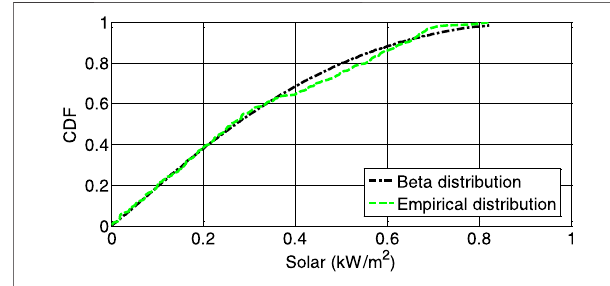
FIGURE 7 | CDF of solar radiation.